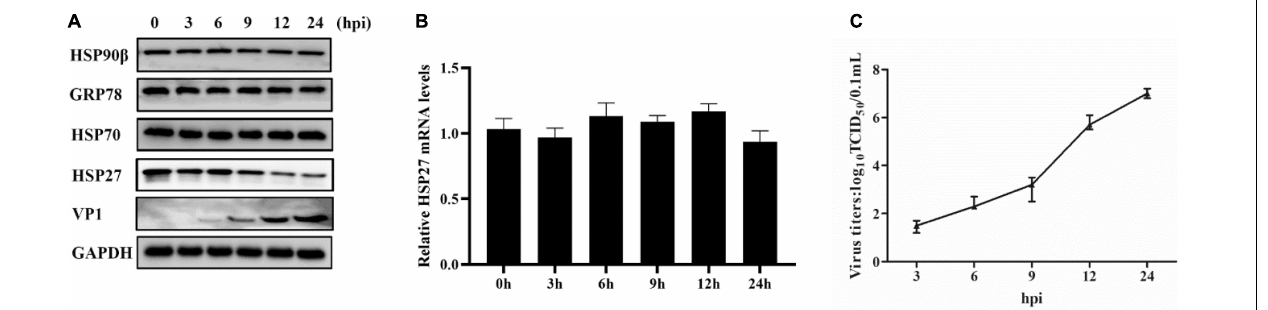
FIGURE 1 | Encephalomyocarditis virus (EMCV) infection degrades HSP27 protein expression in A549 cells. A549 cells were infected with EMCV at an multiplicity of infection (MOI) of 0.1 for 0, 3, 6, 9, 12, or 24 h. (A) The expression of HSP27, VP1, HSP90 β , GRP78, and HSP70 were analyzed by immunoblotting. GAPDH was used as a loading control. (B) HSP27 mRNA levels were measured by RT-qPCR. (C) Cells and supernatant were harvested, and viral titers were determined by TCID 50 assay (Reed-Muench